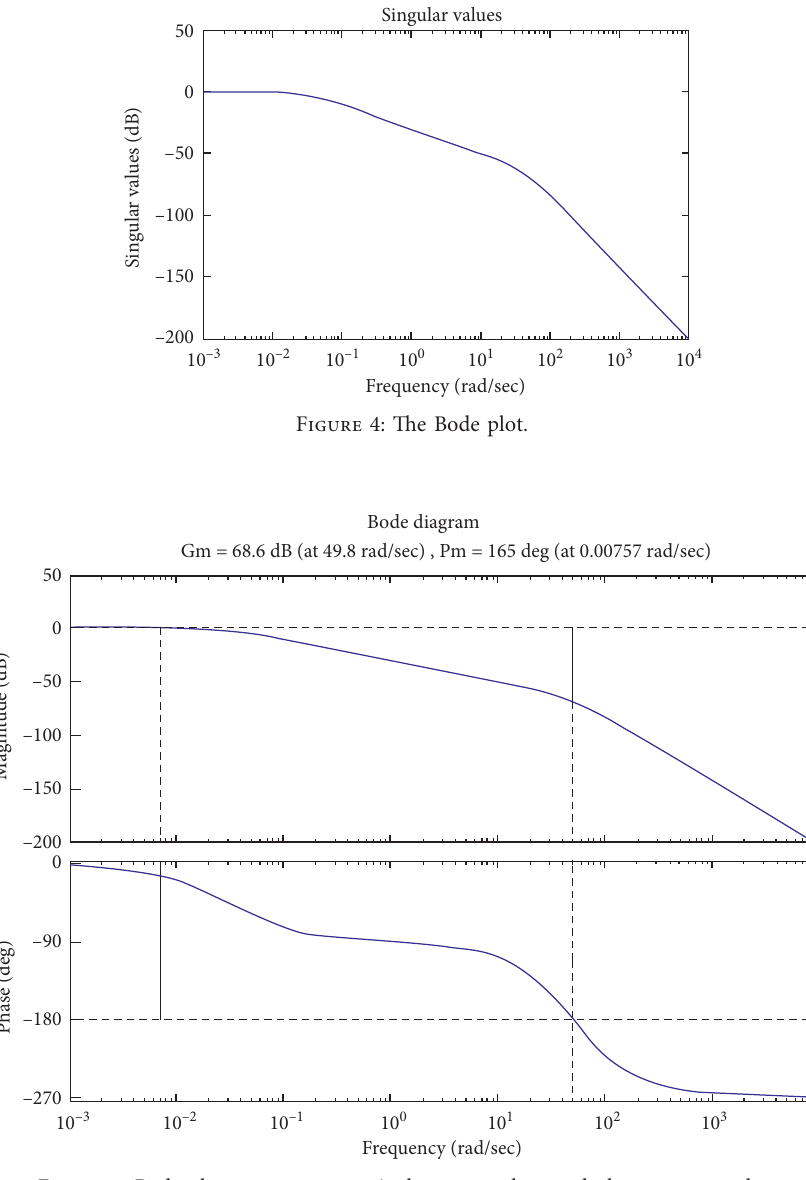
Figure 5: Bode plots represent marginal reserve values and phase reserve values.